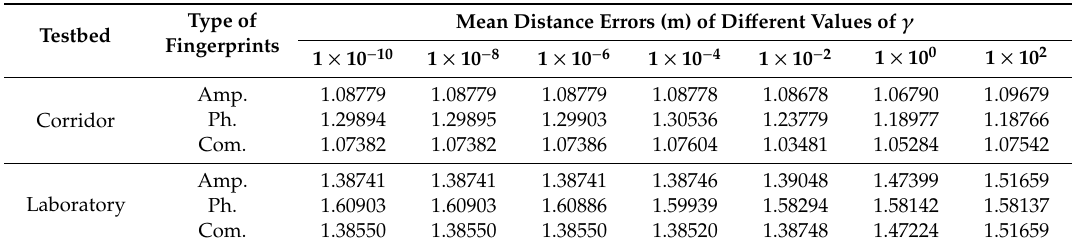
Table 5. The e ff ects of di ff erent values of γ on mean distance